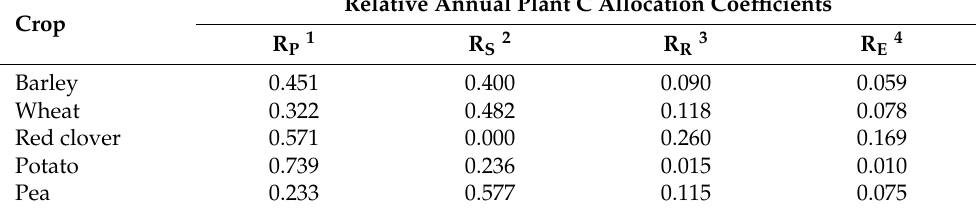
Table 2. Relative annual plant carbon (C) allocation coefficients for the main crop (taken from Bolinder et al. [43,44]; Kauer et al.